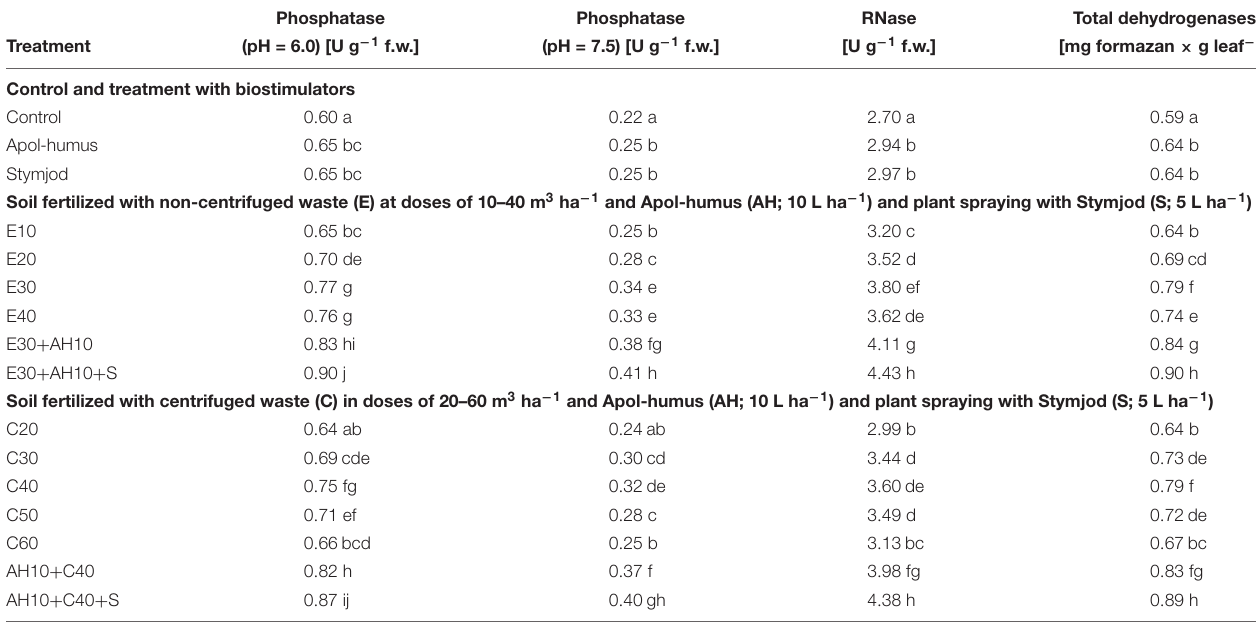
TABLE 7 | Activity of selected enzymes in leaves of sorghum the plants cultivated in field and fertilized with liquid, non-centrifuged and centrifuged waste from a biomass biodigestion to methane, Apol-humus and Stymjod. Phosphatase Phosphatase RNase Total dehydrogenases Treatment (pH = 6.0) [U g − 1 f.w.]